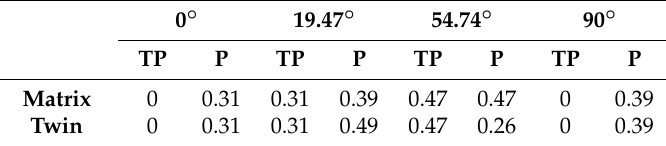
Table 3. Maximum Schmid factors of twinning partial (TP) and partial (P) under different twin orientation